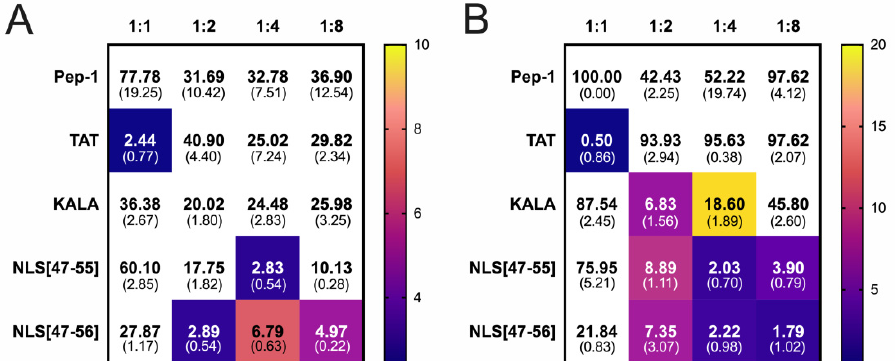
Figure 20. Results of 48 h culture in the presence of complexes in CRs of 1:1, 1:2, 1:4 and 1:8. The complexes were formed using incubation of 2 μ g pmaxGFP with chosen CPPs at 37 °C for 30 min. Bar = 50 μ m. CR, charge ratio.